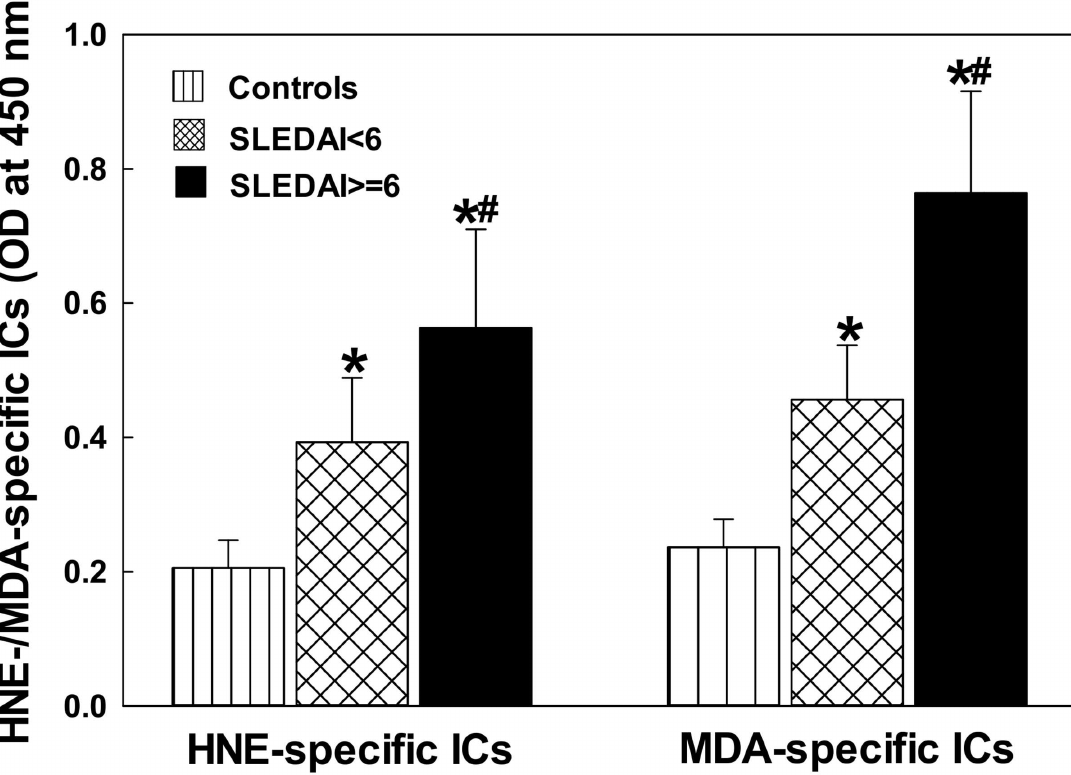
Fig 2. Serum HNE- and MDA-specific ICs in SLE patients with SLEDAI < 6 (n = 28) and SLEDAI (cid:21) 6 (SLEDAI > = 6 in the figure; n = 32) vs. controls (n = 32). The results are means ± SD. * p < 0.05 vs. controls; # p < 0.05 vs. SLEDAI < 6 patients.